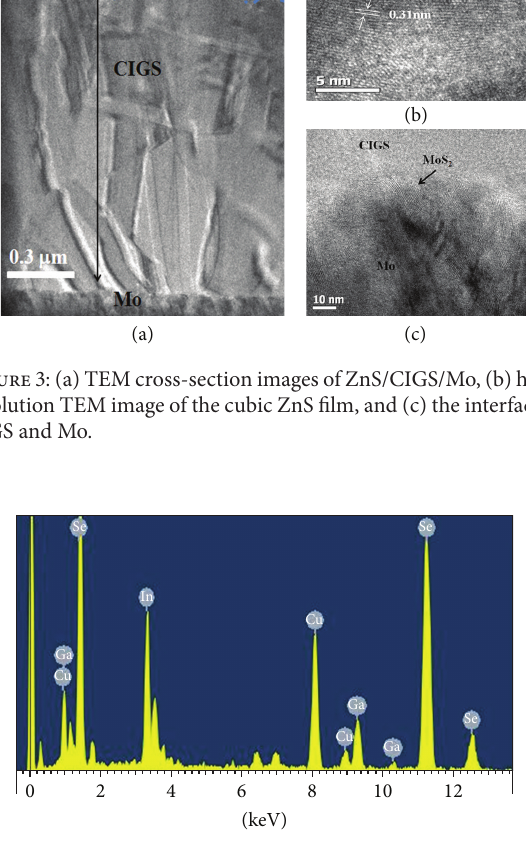
Figure 4: EDX analysis of the CIGS